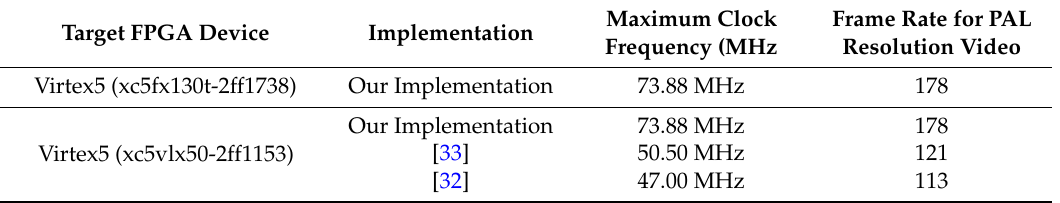
Table 2. Performance Comparison with Existing Motion Detection